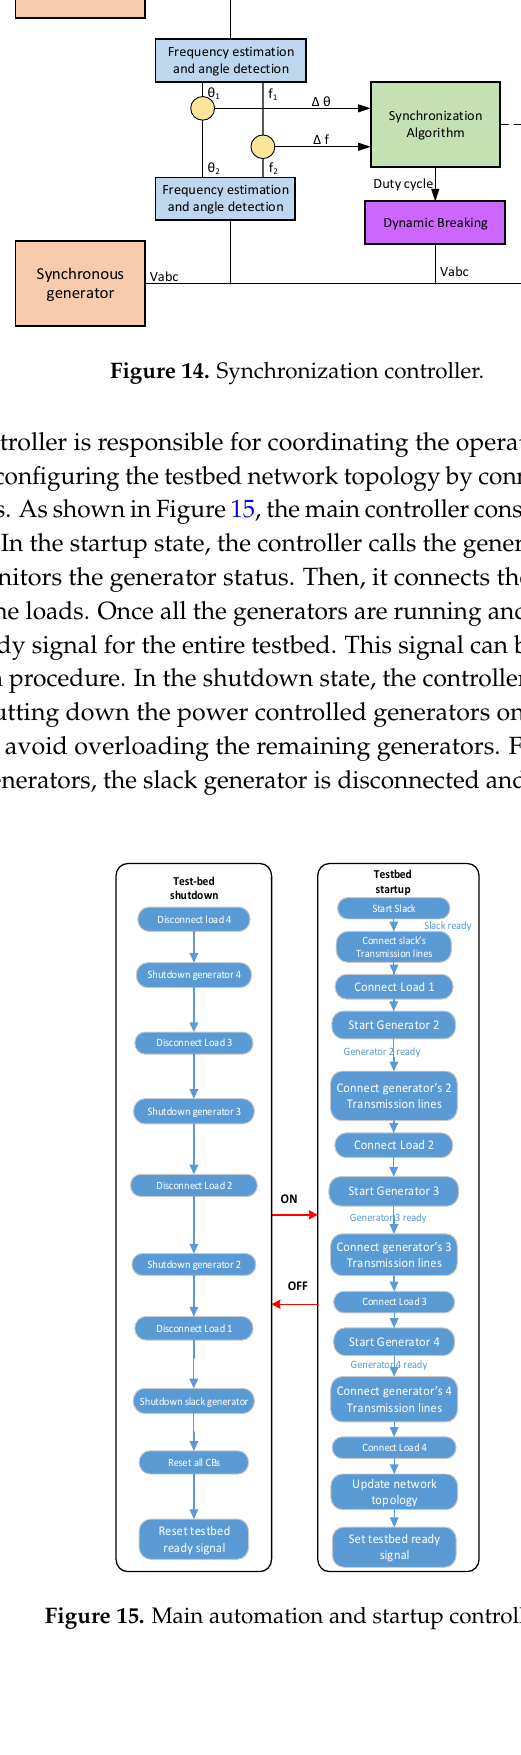
Figure 13. Power controlled generator control.